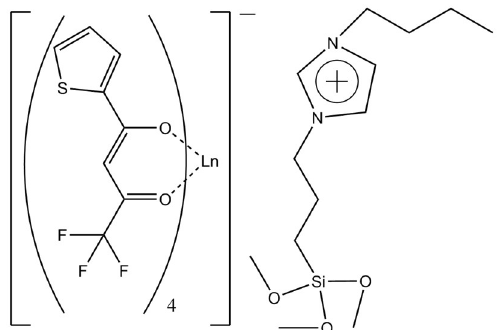
Figure 1. Schematic structure of the non-hydrolyzed lanthanide (Ln = Tb/Eu)-based ISs: 1-butyl-3-[3-(trimethoxysilyl)propyl]imidazolium tetra(2-thenoyltrifluoroacetonate)terbate/europate (III) [B(TMSP)Im][Ln(TTA) 4 ].